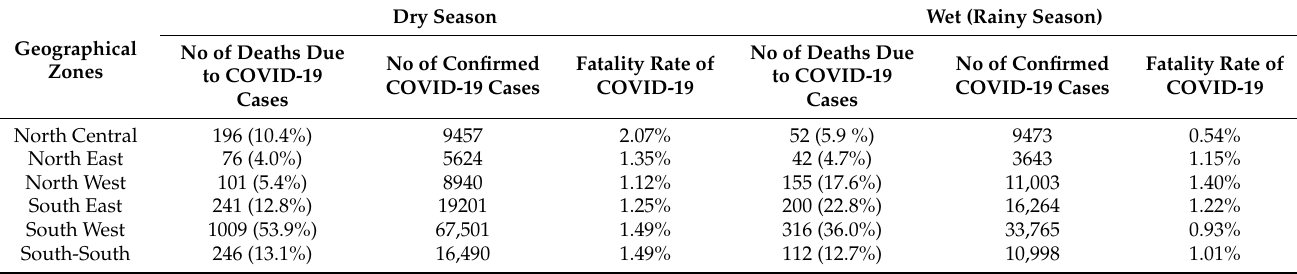
Table 4. Fatality Rate of COVID-19 during the Dry and Wet Seasons across the Geographical Regions in